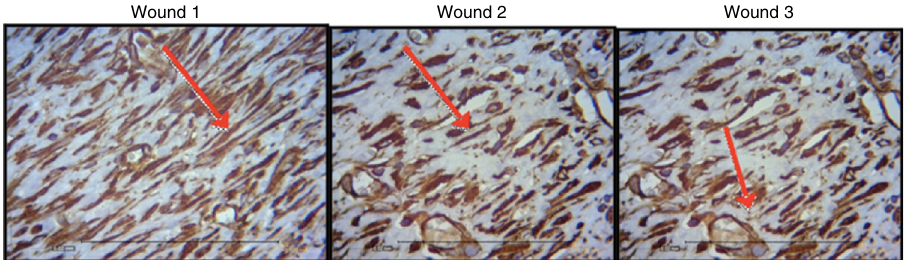
Figure 10 Photomicrograph of vimentin --- where macrophages, fibroblasts, and vessels are evaluated, on the 15th day of evolution, in wounds 1, 2, and 3 (VIM ×